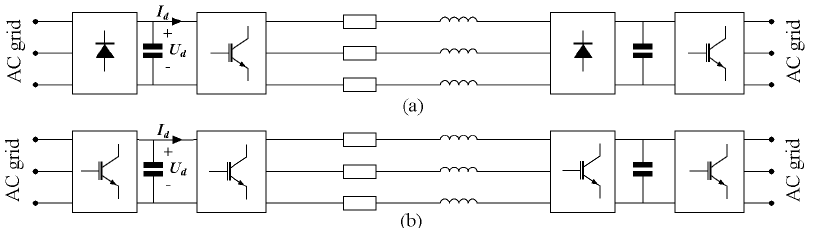
Figure 2. Proposed scheme of power transmission for: ( a ) Unidirectional power flow; ( b ) Bidirectional power flow.